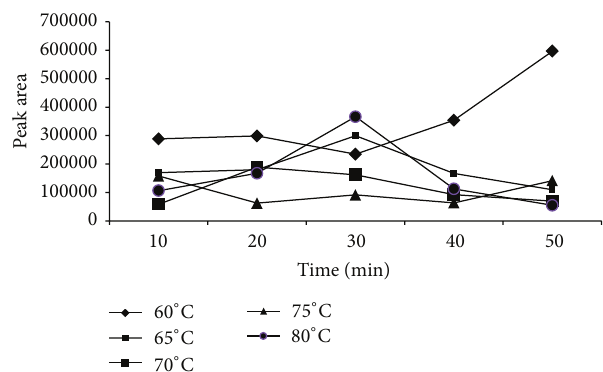
Figure 4: Effects of temperature on the memantine fluorescent derivative formation.